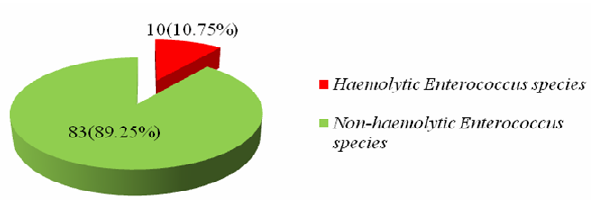
Fig. 1. Prevalence of generic enterococci in healthy beef